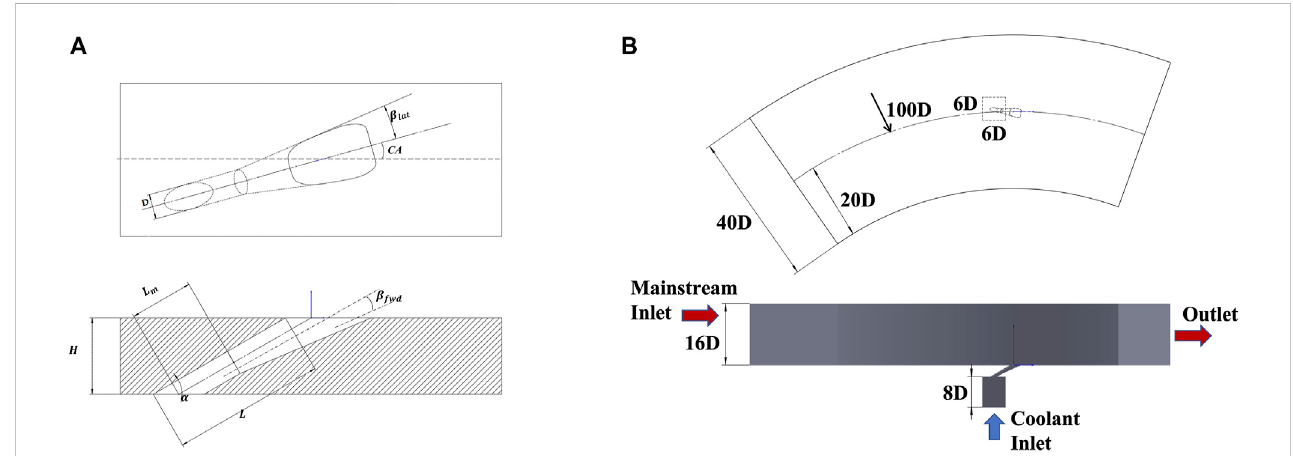
FIGURE 1 (A) Geometry of seven-to-seven fi lm-cooling hole, and (B) the structure of the fl ow tunnel including the mainstream and coolant.